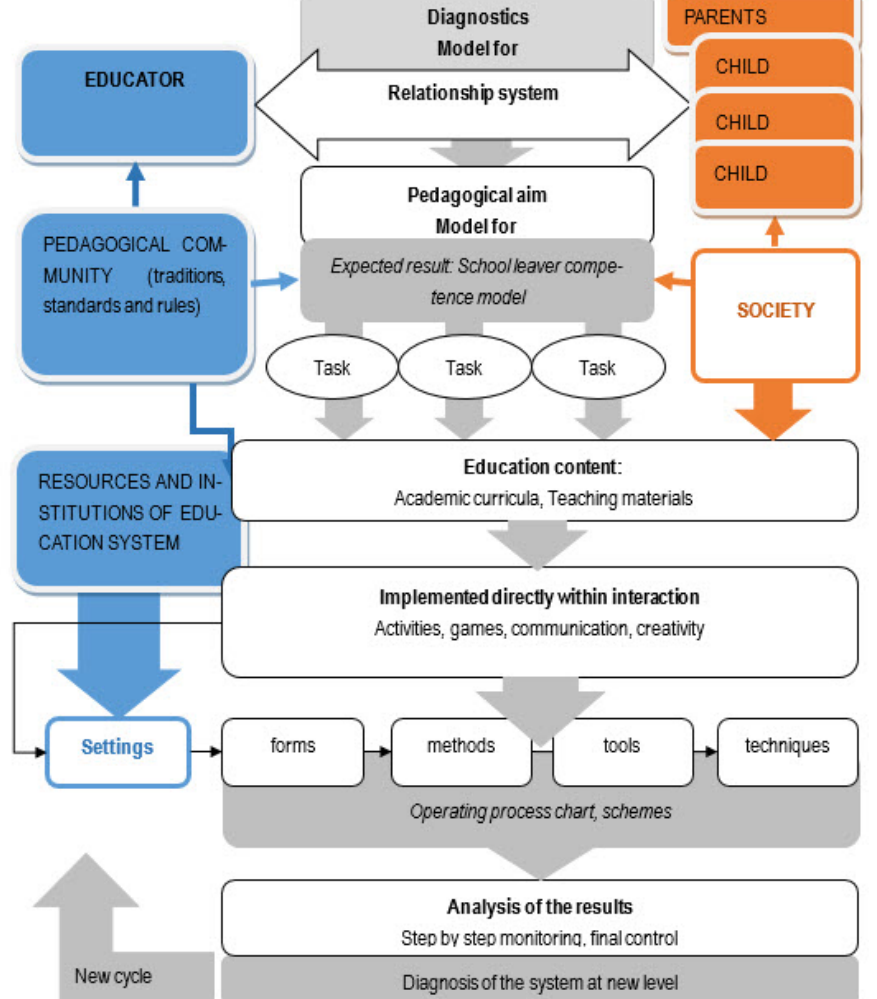
Figure 1. Structural components of the pedagogical